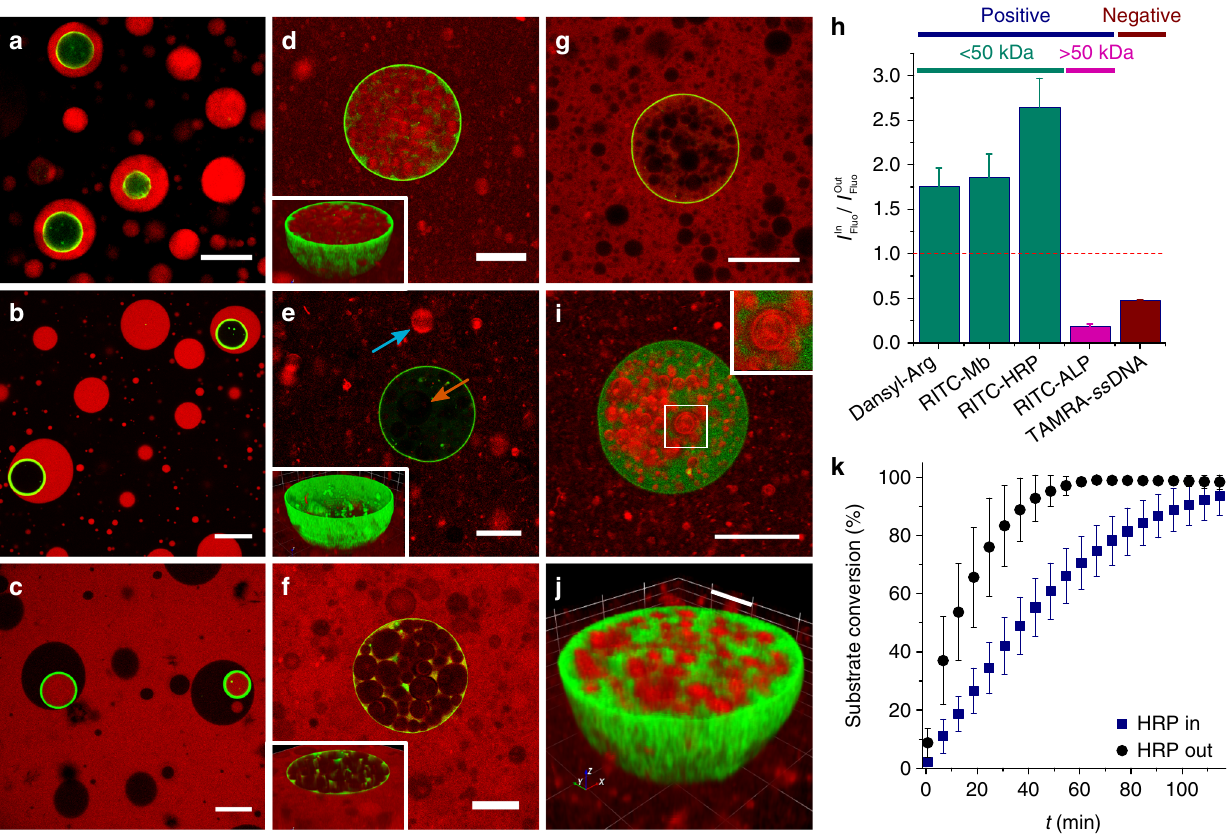
Fig. 4 Payload reorganisation in self-recon fi gurable host – guest protocells. a - f Confocal fl uorescence microscopy images showing host – guest protocells consisting of GOx-containing FITC-labelled proteinosomes (green) entrapped within micelle coacervate droplets (unlabelled) prepared in the presence of red fl uorescent RITC-HRP ( a ), RITC-ALP ( b ) or TAMRA- ss DNA ( c ), and after proteinosome-mediated disassembly of the host coacervate droplets ( d – f , respectively). Initially, RITC-HRP and RITC-ALP are sequestered in the coacervate phase ( a , b ), whilst TAMRA- ss DNA is con fi ned to the water- fi lled proteinosome interior and external solution ( c ). Enzyme-mediated disassembly gives rise to RITC-HRP transfer to the lumen of fatty acid vesicles housed within the proteinosome interior or present in the external solution ( d ), RITC-ALP transfer to vesicles formed outside the proteinosomes ( e , blue arrow), but excluded from the proteinosome-internalised vesicles ( e , orange arrow) and release of TAMRA- ss DNA to the external solution without transfer to the vesicles ( f ). Insets in d – f show 3D reconstructions of the proteinosomes. g Control experiments involving addition of RITC-HRP after completion of the micelle coacervate-to-vesicle transition showing no uptake of the solute by the preformed fatty acid vesicles. h Plot of normalised solute fl uorescence intensity ( I IN / I OUT ) associated with vesicle-in-proteinosome hybrid protocells showing dependence of molecular weight and surface potential on payload uptake into the recon fi gured nested protocells. Error bars represent the standard deviation of the ratio of fl uorescence intensities. i Confocal fl uorescence microscopy image of a single guest proteinosome prepared with a non- fl uorescent membrane and containing FITC-GOx, and recorded after disassembly and transformation of the host – guest protocell. FITC-GOx molecules are excluded from the proteinosome-internalised Nile Red-stained fatty acid vesicles. Inset in i shows high-magni fi cation image. j 3D reconstruction of a single guest proteinosome prepared with a non- fl uorescent membrane and containing FITC-GOx, and recorded after disassembly and transformation of a host coacervate encapsulating RITC-HRP. RITC-HRP-containing vesicles (red) are housed within the FITC-GOx-containing (green) proteinosome. k Plots of time-dependent HRP-mediated conversion of Amplex Red into resoru fi n measured for vesicle/proteinosome guest – host protocells containing vesicle-entrapped HRP (blue), or control experiments in which HRP was added to the external phase of a vesicle suspension (black). Error bars represent the standard deviation of the substrate conversion ( n = (Fig. 4f). Control experiments in which the payloads were added to dispersions of preformed vesicles showed no evidence for uptake through the fatty acid membrane (Fig. 4g and Supplementary Fig. 13), indicating that in situ assembly of the vesicles from fatty acid monomers present within the proteino- some interior was responsible for solute encapsulation. The above observations were quanti fi ed by measuring the fl uorescence intensities associated with the payloads present inside or outside the proteinosomes after GOx-mediated recon fi guration. For example, internalisation of the fatty acid vesicles within the proteinosomes resulted in a 1.7 to 2.6-fold accumulation of positively charged, low-molecular weight solutes (RITC-HRP, α - dansyl- L -arginine or RITC-labelled Mb) compared with the external continuous phase (Fig. 4h).